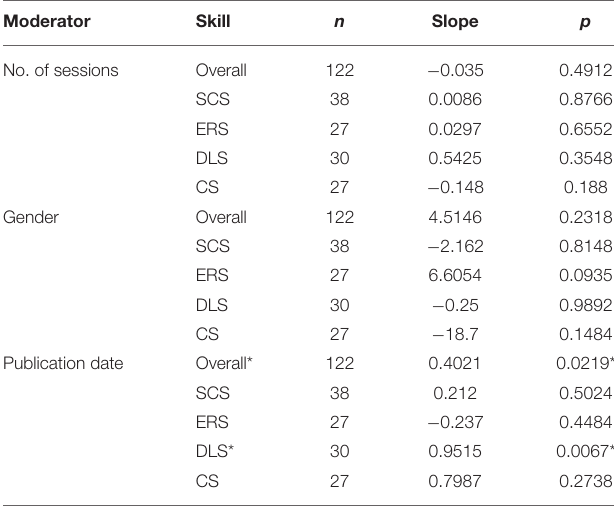
TABLE 4 | Metaregression results for number of sessions, sex, and publication date moderators. Moderator